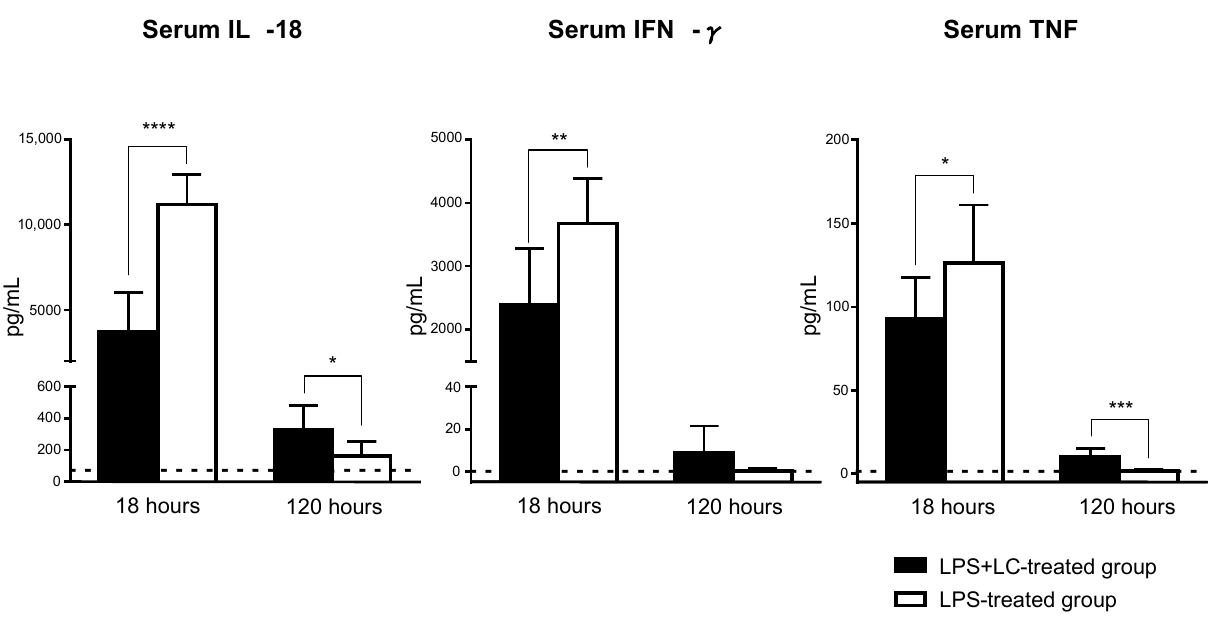
Figure 6. Effect of LC on serum proinflammatory cytokines after LPS injection. Serum IL-18, IFN- γ , and TNF were measured as biomarkers in AKI. Dotted lines: Mean values from saline-injected group without LPS. The data are mean ± SEM. * p < 0.05, ** p < 0.01, *** p < 0.005, **** p < 0.001, LPS- vs. LPS + LC-treated group. Table 3. Renal mRNA expression of cytokines, chemokines, KIM-1, Th cell subset transcription fac- tors, and leukocyte adhesion molecules by real-time PCR.